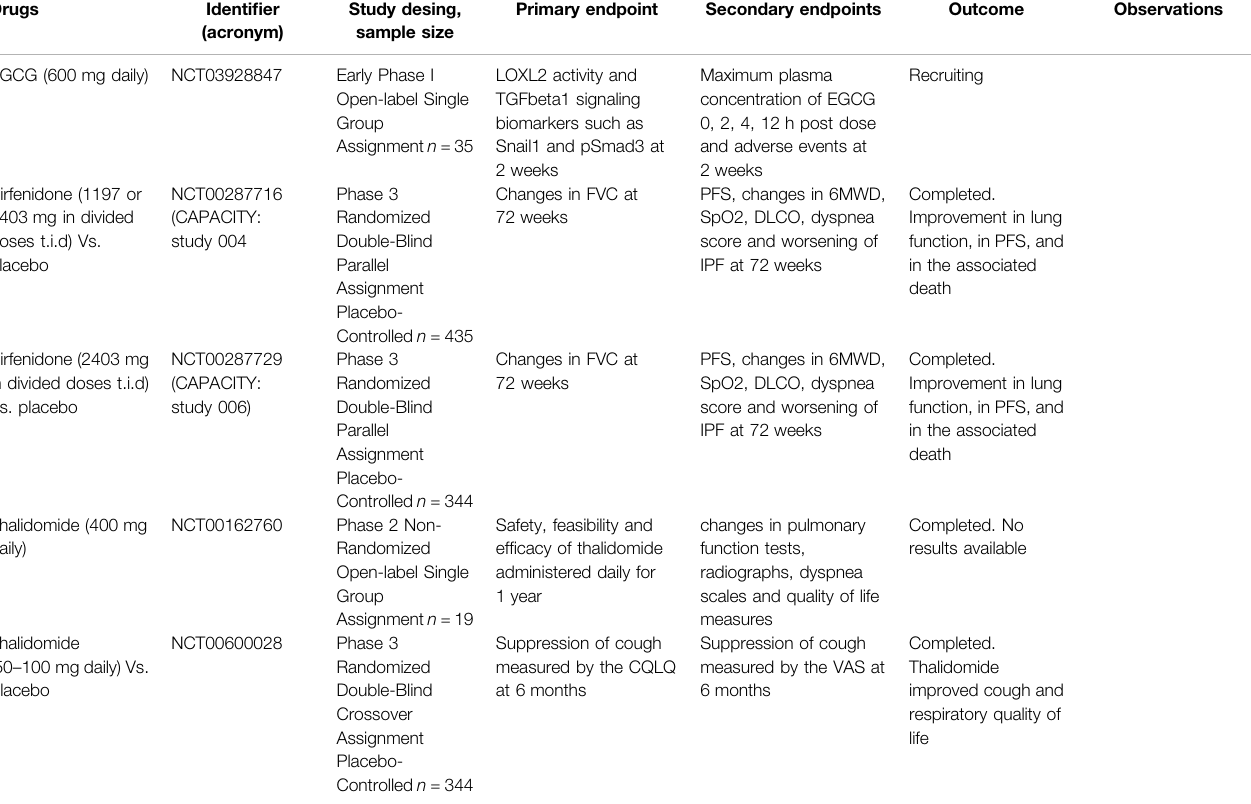
TABLE 4 | ( Continued ) Summary of clinical trials of antioxidant therapies of